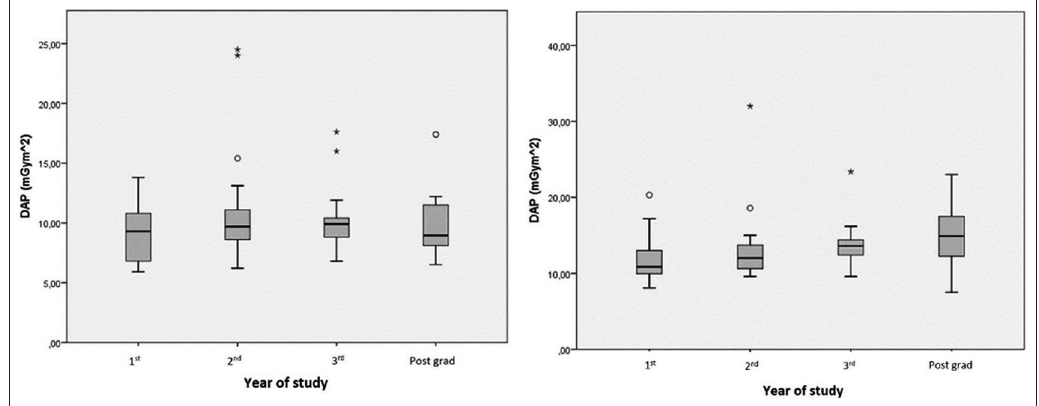
FIGURE 1. Dose area product comparison between study years for anteroposterior view (left) and lateral view (right) of useful images of the thoracic spine.